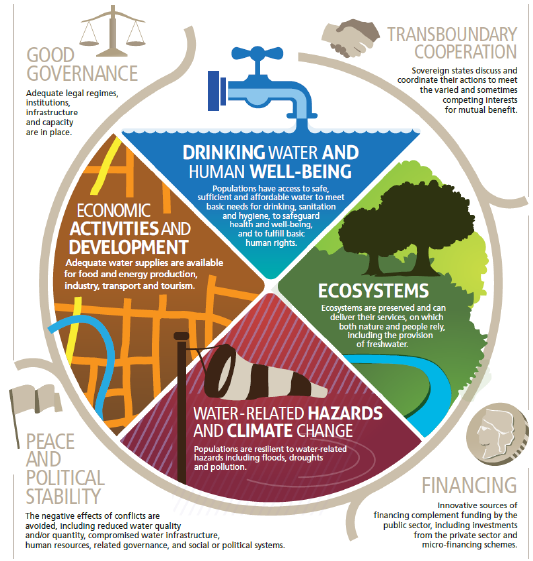
Figure 1. United Nation (UN)-Water’s conceptual framework [11].